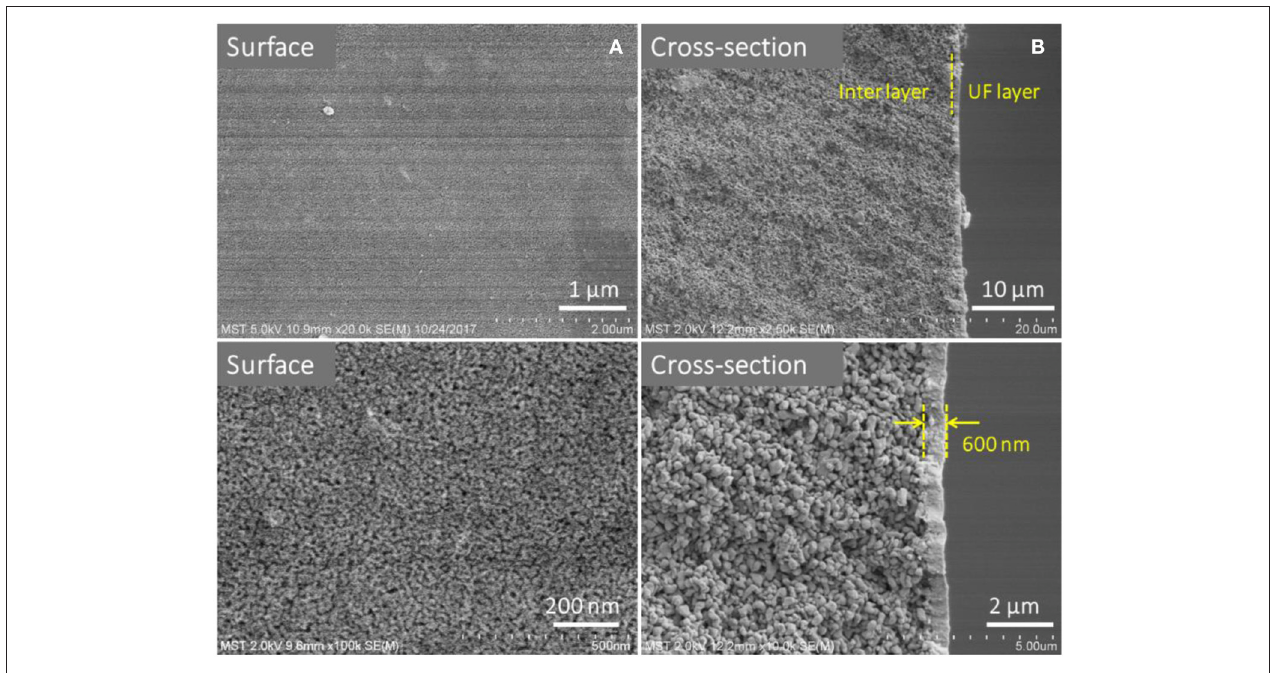
FIGURE 9 | FESEM images of ZrO 2 UF membranes: (A) Surface and (B) Cross-section.